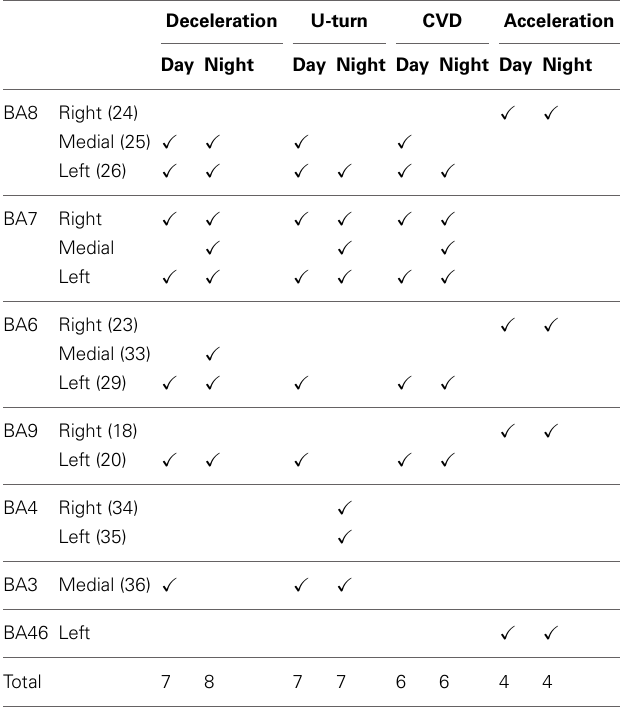
Table 1 | Areas where (cid:2) COE clearly increased ( (cid:2) ) in each part of the experiment.